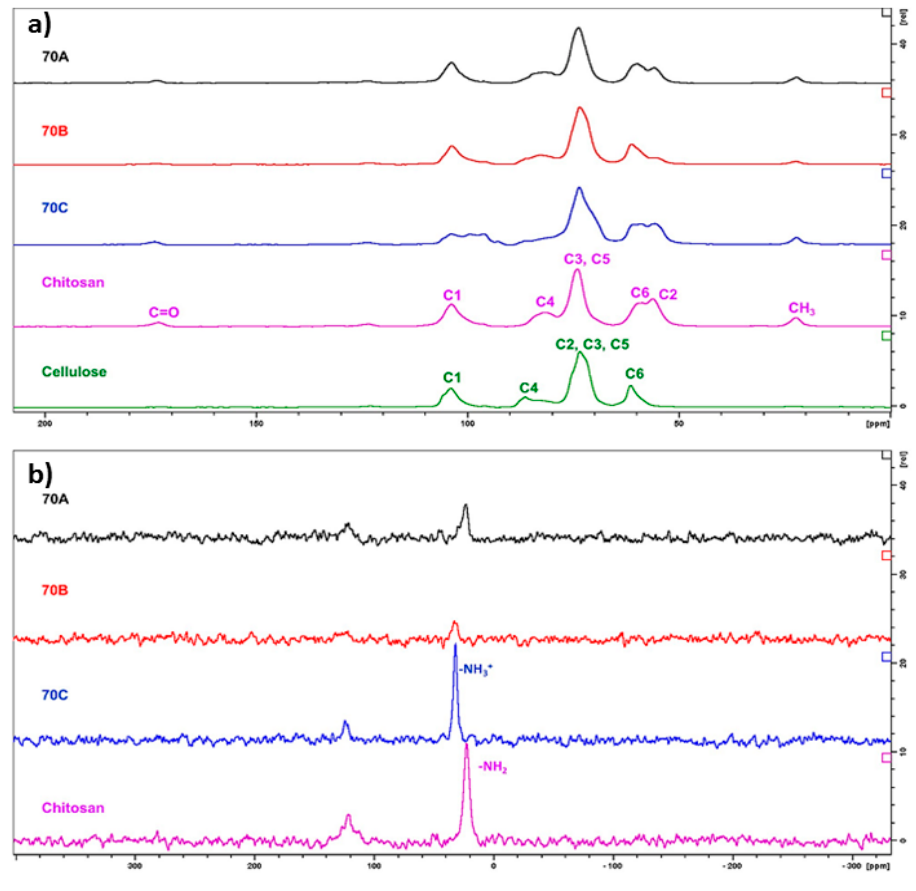
Figure 3. ( a ) CP-MAS 13 C NMR spectra ( b ) CP-MAS 15 N NMR spectra of chitosan, cellulose, 70A , 70B, and 70C chitosan-cellulose lyophilized hydrogel beads.